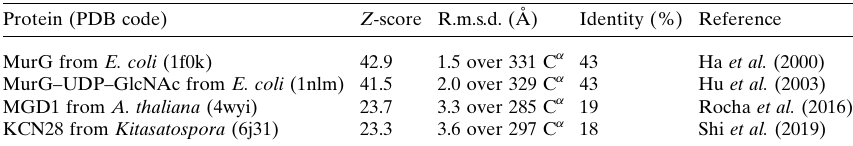
Table 2 Structural similarity search using DALI